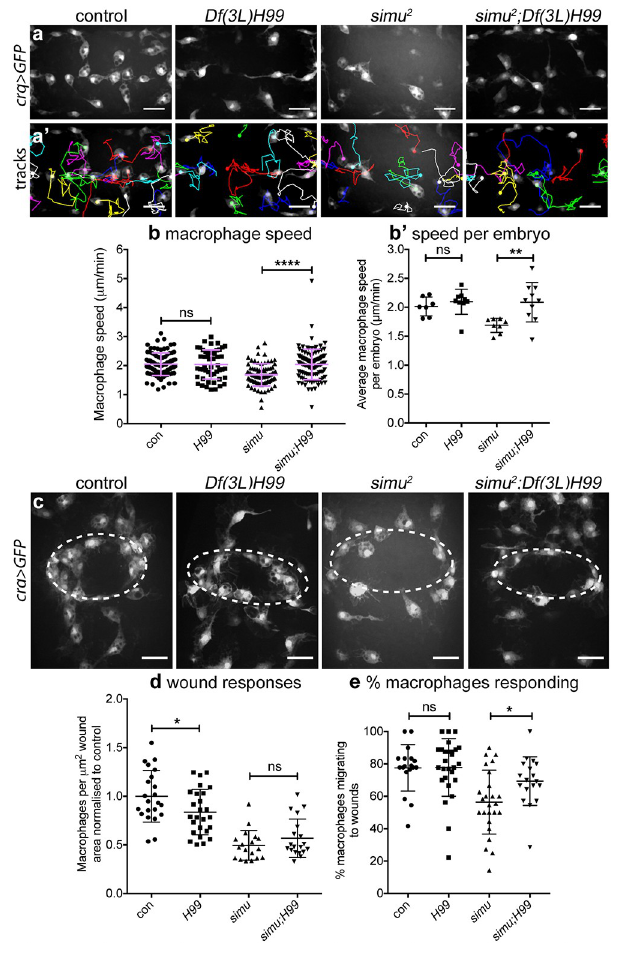
Fig 6. Removal of apoptosis from simu mutants rescues wandering migration and initial responses to wounds. (a– a’) Maximum projections of GFP-labelled macrophages on the ventral midline at stage 15 (a) and tracks of their migration in the subsequent 60 minutes (a’) in controls, apoptosis-null embryos ( Df(3L)H99 ), simu mutants ( simu 2 ) and simu mutants that lack apoptosis ( simu 2 ; Df(3L)H99 ). (b–b’) Scatterplots of speed per macrophage (b) and average speed per embryo (b’) in μ m per min at stage 15 in control and apoptosis-null embryos ( n = 7 and 9, respectively; P = 0.252, Mann–Whitney test), and simu mutants and simu mutants that lack apoptosis ( n = 8 and 10, respectively; P = 0.006, Mann–Whitney test, b’). (c) Maximum projections of macrophages at wounds 60-minutes post wounding in indicated embryos; dotted white ellipses show wound edges. (d) Scatterplot of wound responses (macrophage density at wounds normalised to control average) comparing control and apoptosis-null embryos ( n = 22 and 26, respectively; P = 0.039, Mann–Whitney test), and simu mutants and simu mutants that lack apoptosis ( n = 18 and 19, respectively; P = 0.30, Mann–Whitney test). (e) Scatterplot of percentage of responding macrophages (percentage that migrate to the wound that were not at the wound at t = 0 minutes) comparing control and apoptosis-null embryos ( n = 18 and 27, respectively; P = 0.80, Mann–Whitney test), and simu mutants and simu mutants that lack apoptosis ( n = 25 and 18, respectively; P = 0.019, Mann–Whitney test). Genotypes for all embryos: control ( w;;crq-GAL4 , UAS-GFP ), Df(3L)H99 ( w;;Df(3L)H99 , crq-GAL4 , UAS-GFP ), simu 2 ( w;simu 2 ; crq-GAL4 , UAS-GFP ) and simu 2 ; Df(3L)H99 ( w;simu 2 ; Df(3L)H99 , crq-GAL4 , UAS-GFP ). Lines and error bars in scatterplots show mean and standard deviation; ns, � , �� , ���� denote not significant, P < 0.05, P < 0.001, and P < 0.0001; scale bars represent 20 μ m. All data used to plot graphs may be found in Supporting information file S1 Data. GFP, green fluorescent protein; UAS, upstream activating